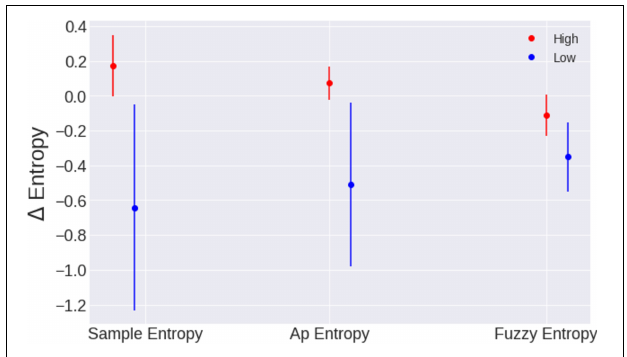
FIGURE 7 | Comparison of people with high physical activity and people with low physical activity for the three entropy methods, ApEn, FuzzyEn, and SampEn. The means of these populations are statistically different with p values 0.0011, 0.0052, and 0.0033 for the three methods, respectively.